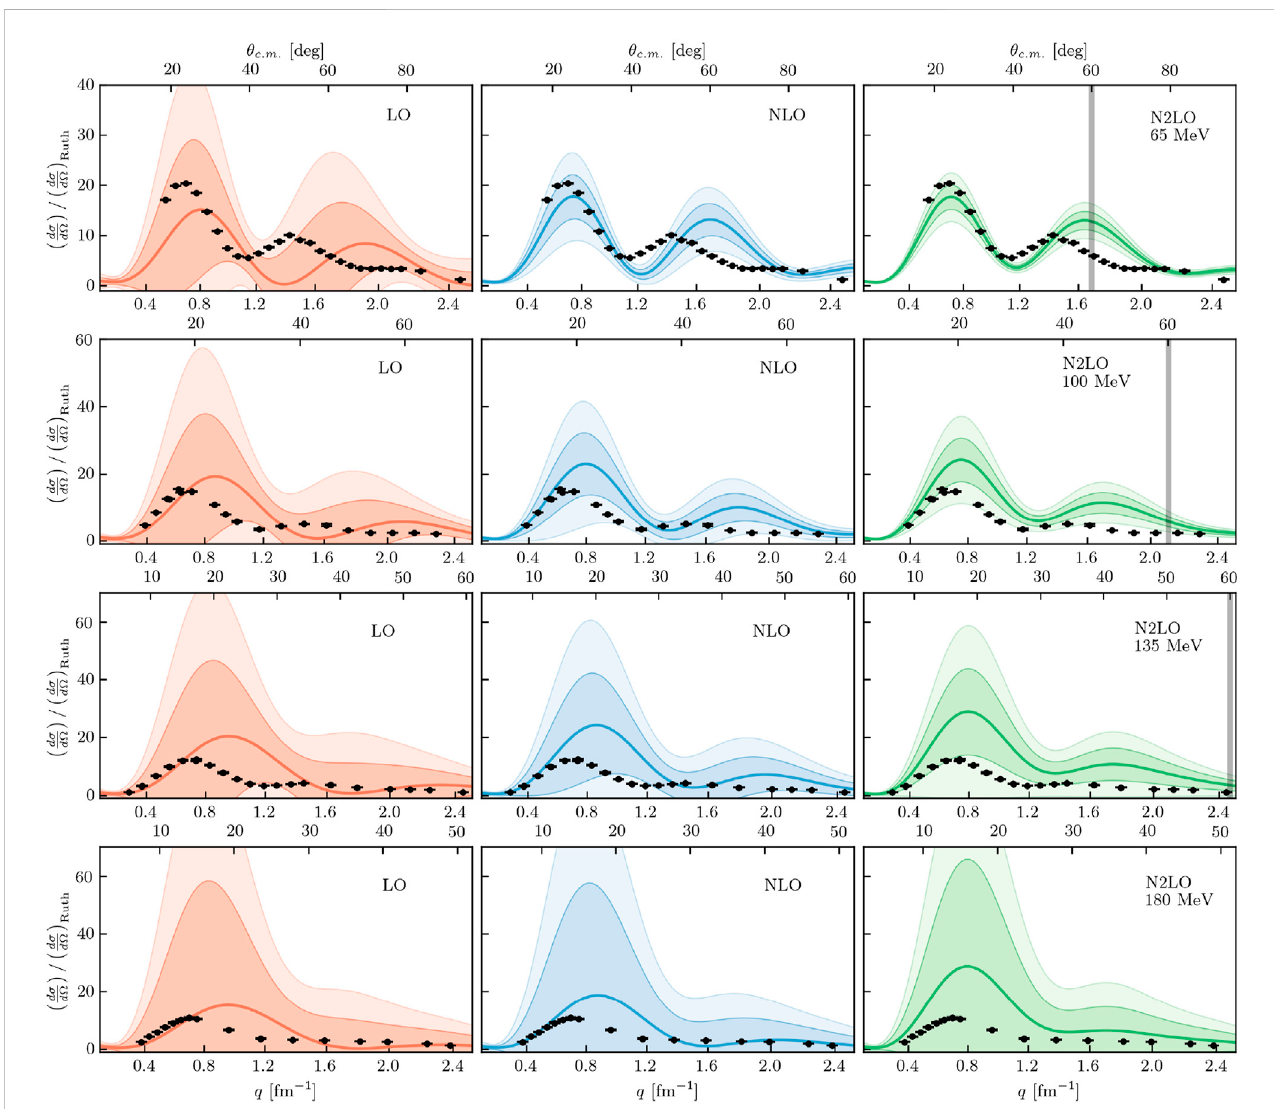
FIGURE 8 DifferentialcrosssectiondividedbyRutherfordforprotonscatteringon 16 Oat( fi rstrow)65 MeV,(secondrow)100 MeV,(thirdrow)135 MeV,and(fourth row) 180 MeV for LO (left column), NLO (middle column), and N2LO (right column) with corresponding 1 σ (darker bands) and 2 σ (lighter bands) error bands. Black dots are experimental data from Ref. [85] (65 MeV) [86], (100 MeV) [87], (135 MeV), and [88] (180 MeV). Figure taken from Ref.